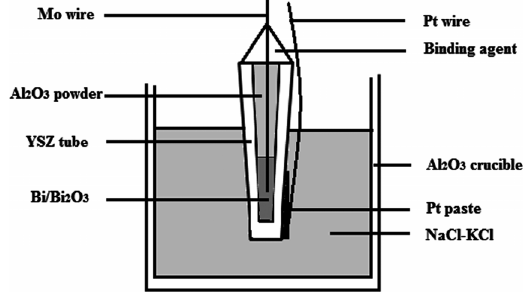
Fig. 2 Results of accuracy measurements performed using the Bi/Bi 2 O 3 sensor at variable temperatures.